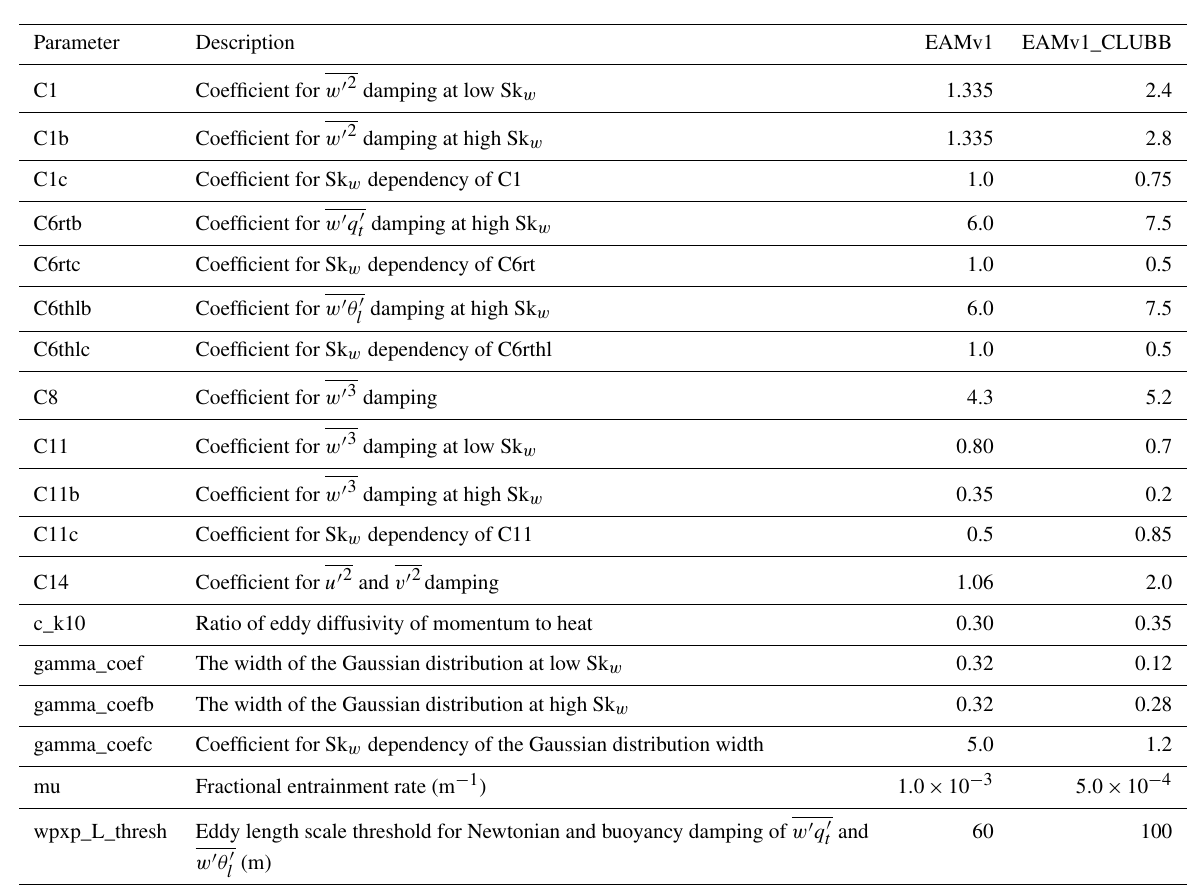
Table 2. Description of tunable parameters and their values in EAMv1 and EAMv1_CLUBB.